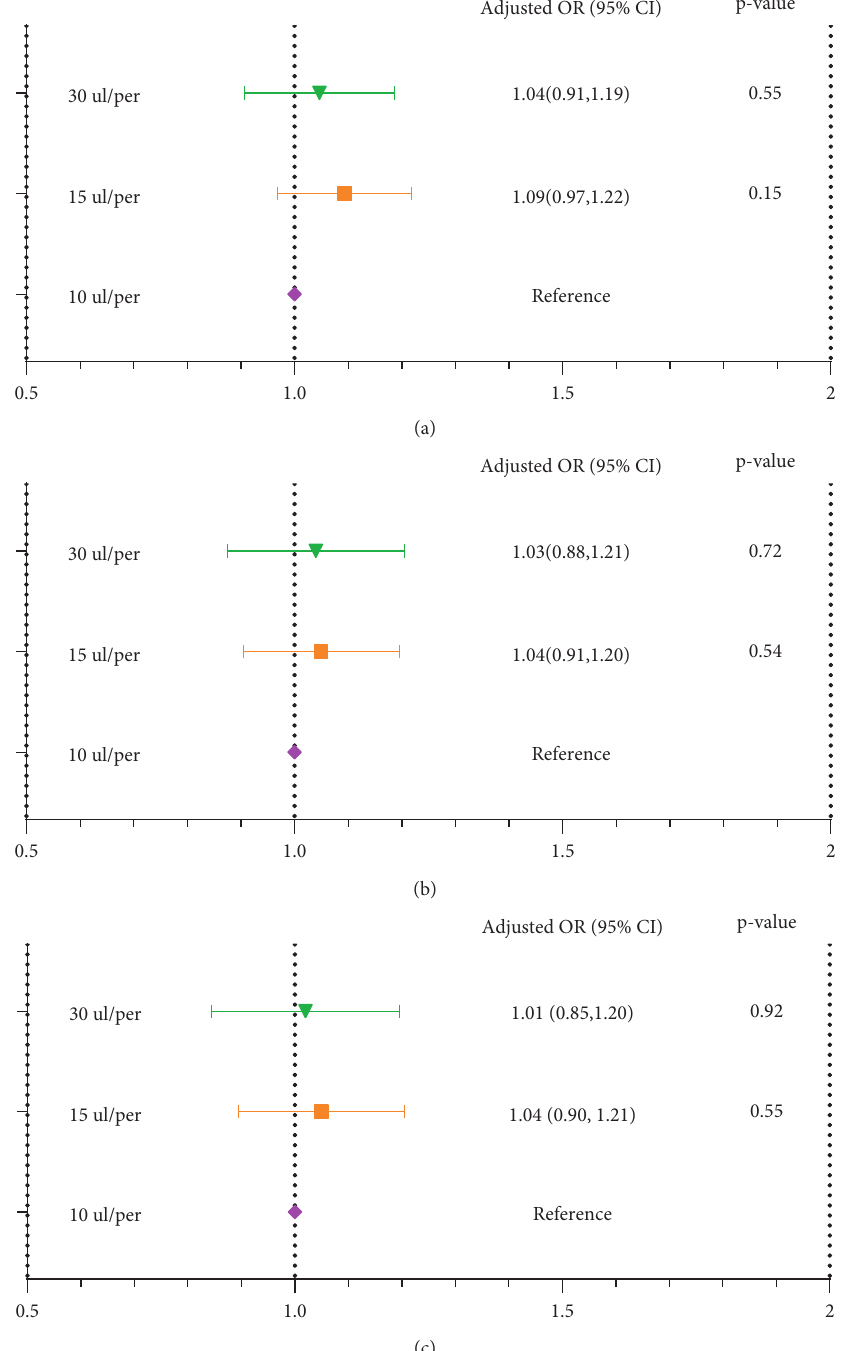
Figure 3: Relationship between embryo density and cleaving speed of day-3 embryos in different models. The analysis was performed by GEE (generalized estimate equation) model, subject ID � patient unique medical record number (independence). (a) Crude model: no factor was adjusted; (b) Model I: the number of retrieved oocytes and AMH were adjusted; (c) Model II: maternal age, paternal age, maternal BMI, type of infertility, type of insemination, COS protocol, AMH, the number of retrieved oocytes, length of stimulation, antral follicles, incubator, and culture medium were